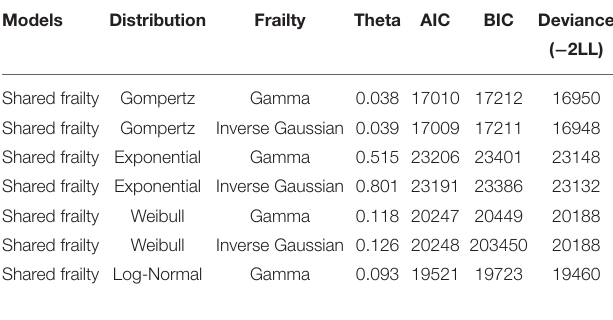
TABLE 3 | Model diagnostics and comparison for the time to resumption of postpartum menses and predictors among reproductive age women in Ethiopia. Models